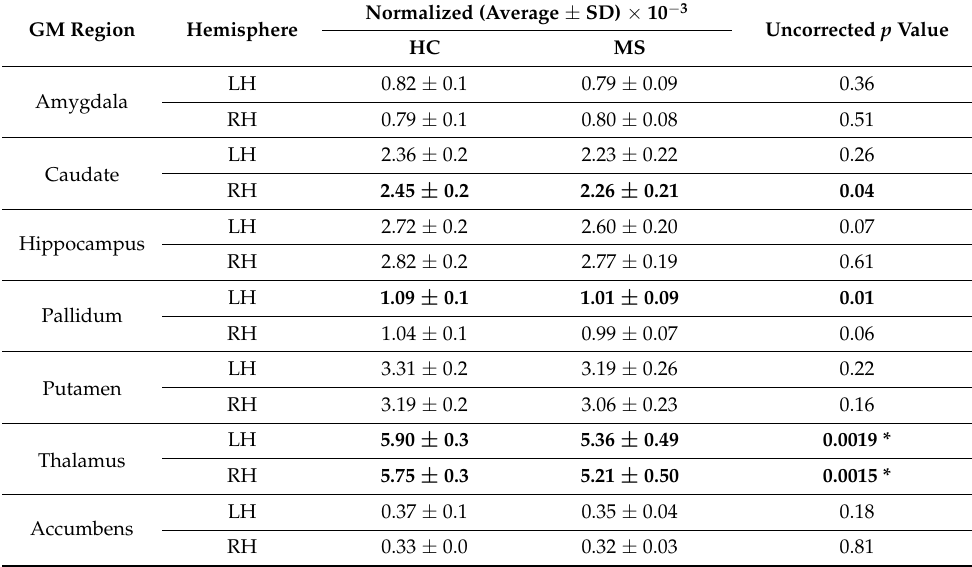
Table 2. Mean volumes of 7 subcortical gray matter structures normalized for total intracranial volume (TIV).